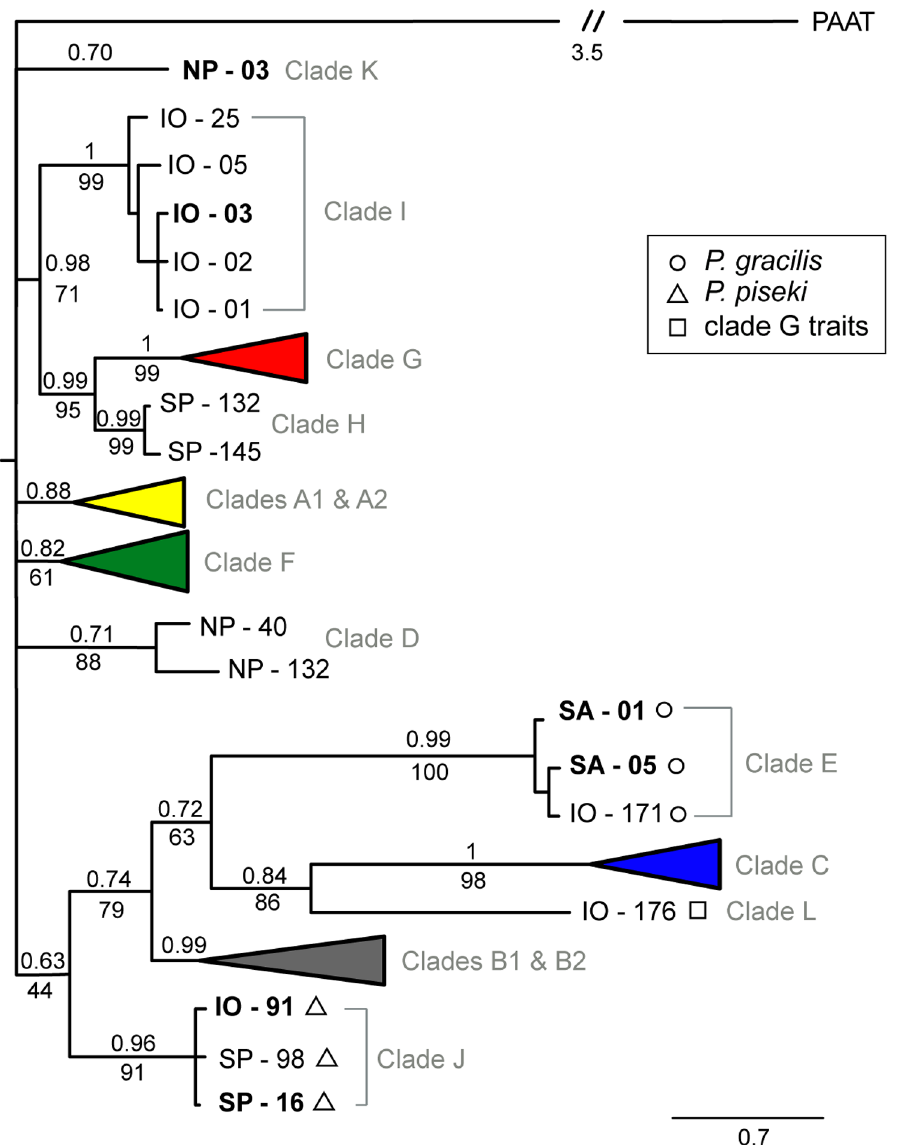
Figure 2. Bayesian phylogeny of 259 unique mtCOII haplotypes in the P.piseki-P.gracilis species complex (610-bp). For clarity, five major clades are condensed into colored triangles on the tree (color as in Fig. 1). These 5 clades are shown in detail in figures 3 & 4. Bayesian posterior probability values are given above the branches, and bootstrap values from maximum likelihood (ML) analyses are given below the branches, when that node was supported in both Bayesian and ML analyses. Bold text indicates haplotypes that were sampled more than once. The tree is rooted, with Pareucalanus attenuatus defined as the outgroup (labeled PAAT; Calanoida, Eucalanidae). The scale bar is in units of substitutions per site (0.7). Shape symbols beside the haplotype identifiers indicate morphological traits of one or more specimens of that haplotype: triangle= P. piseki – like characters, circle= P. gracilis – like characters, square=‘clade G – like’ characters (see Results for more detail). Morphological trait observations for major clades A, B, C, F, G are shown in figures 3 &